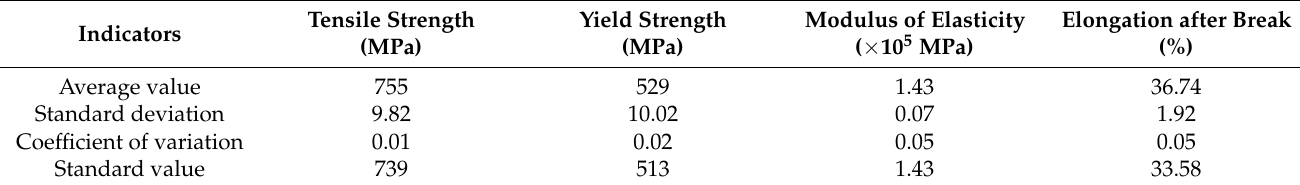
Table 6. The mechanical properties of duplex stainless steel tendons performance index standard values.